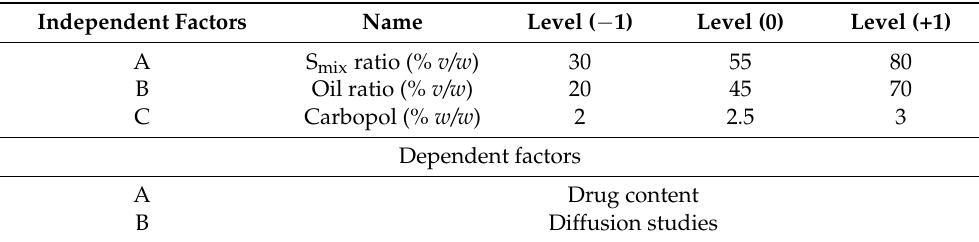
Table 1. A total of 17 runs (trial batches) were generated for transemulgel (Table 2) [23,24]. Table 1. Independent and dependent factors selected and levels for the experiment.